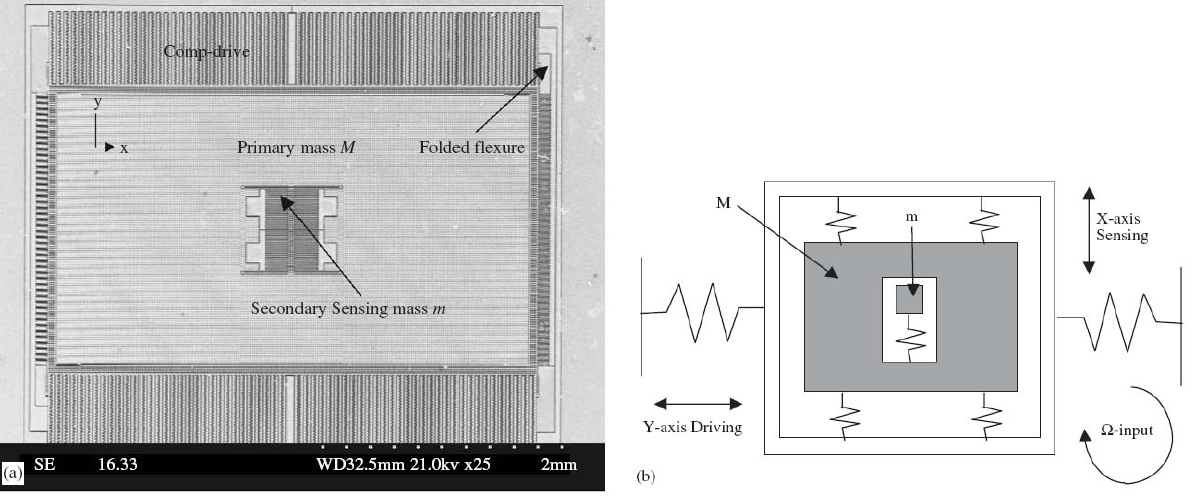
Figure 9. SEM of a gyroscope (a) and its lumped model (b)